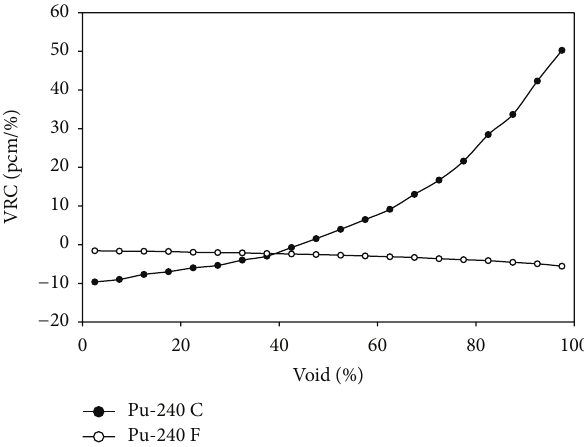
Figure 7: Neutron spectrum for innovative designs of assemblies. Figure 8: Decomposition of VRC values for 240 Pu neutrons capture (C) and fission (F) reactions.